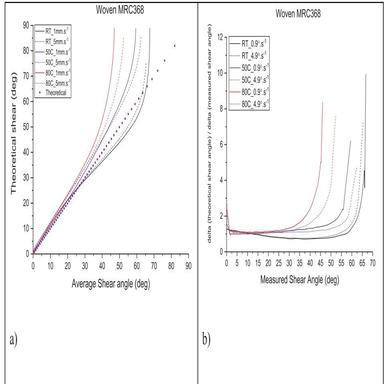
Theoretical and measured shear angles from BE for CEP-TW2 prepreg; a) a direct comparison, and b) slope of 'theoretical to experimental versus measured shear angles (experimental).